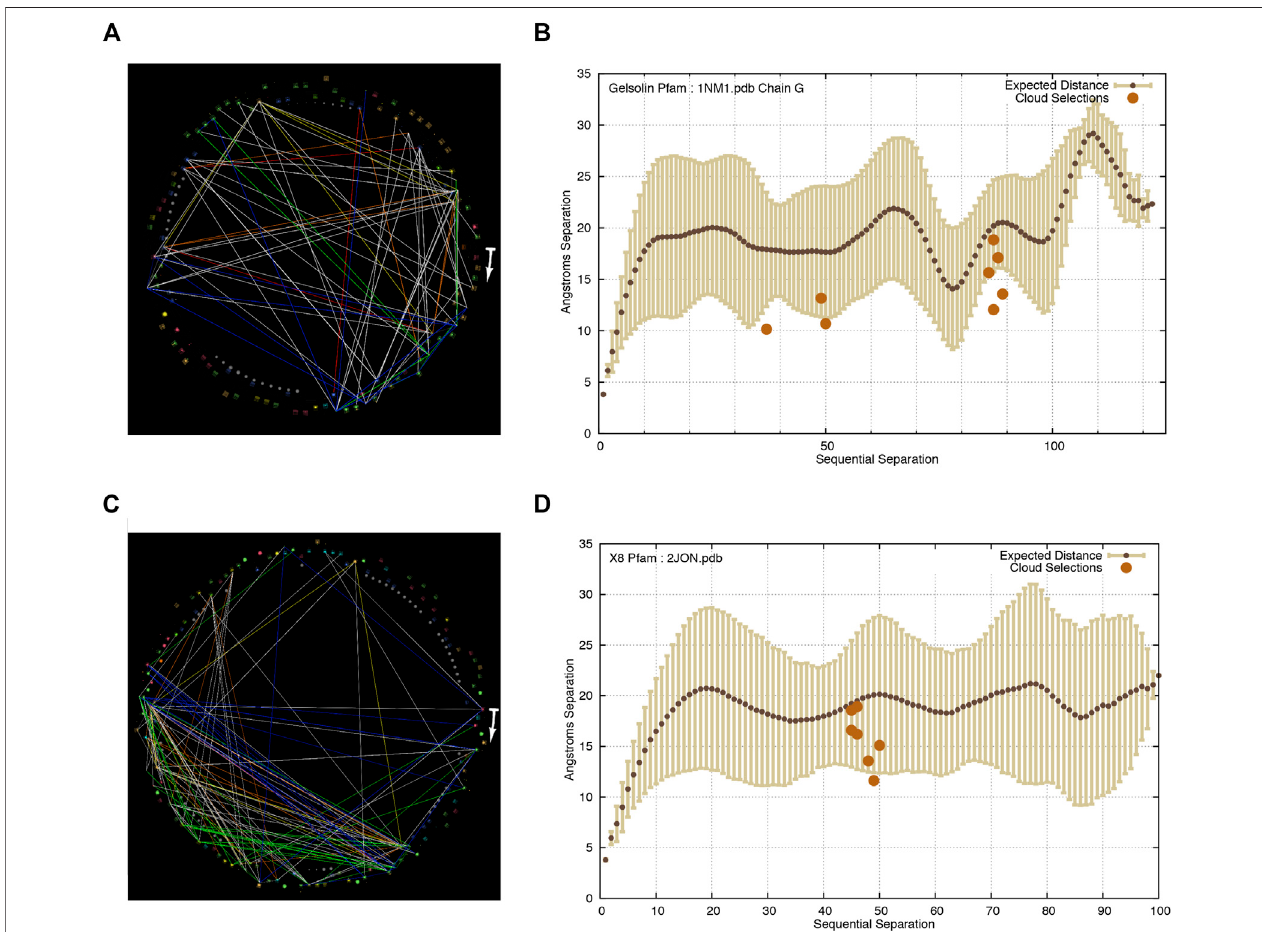
FIGURE 2 | At similar thresholds of T r and P as seen in ADK, other protein families display similar “ clouds ” of weakly co-evolving residue pairs, and similar areas of visually-random or node-link-free space. These residues linked by these weak co-evolution statistics are universally closer than the expected distance for residues of similar sequential separation in their protein structures. The start of the arrows in each image indicates the N-terminal of each protein and it points in the direction of increasingsequencecoordinates.Itshouldbenotedthattherearefewerdistancesplottedintheinter-residuedistanceplotsthanintheStickWRLD diagramofco- evolvingresidues,becausetheinter-residuedistanceplotshowsdistancesforonlythoseresiduepairsthatoccurineachspeci fi cPDB fi le,whiletheStickWRLDdiagram shows allco-evolution acrosseach PFamfamily. (A) Correlatedevolutionstatistics inthegelsolindomain familyvisualizedasnode-links inStickWRLD. T r > =0.12, p < = 0.05. (B) ResiduepairsselectedbyauserasinterestingintheStickWRLDdiagram,plottedagainsttheinter-residuedistancedistributionforthegelsolinPfamfamily,with distances as found in Chain A of the 1NM1 PDB structure. (C) Correlated evolution statistics in the X8 family visualized as node-links in StickWRLD. T r > = 0.1, p < = 0.001. (D) Residue pairs selected by a user as interesting in the StickWRLD diagram, plotted against the inter-residue distance distribution for the X8 Pfam family, with distances as found in the 2JON PDB